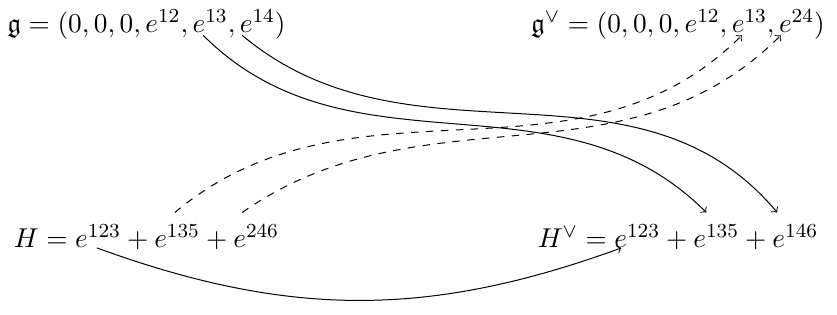
Figure 1 . The diagram shows how to construct the dual of a given admissible